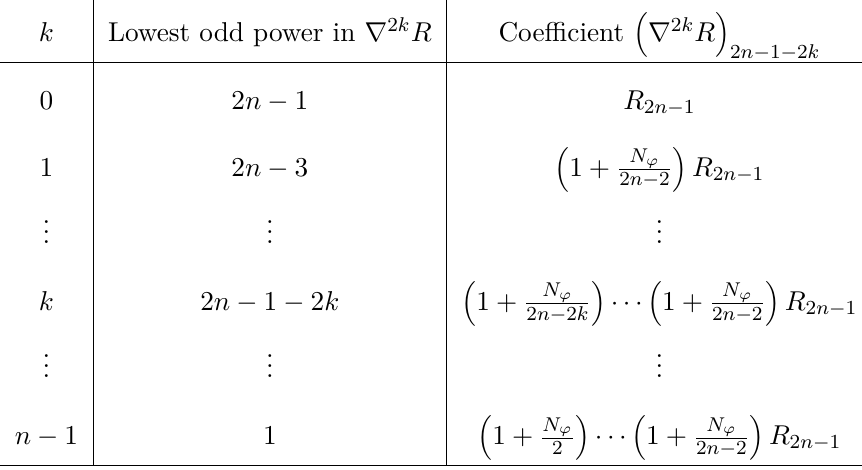
Table 1 . A summary of the relation between the lowest odd power coefficients in the Taylor expansion for ∇ 2 k R in the range 0 ≤ k ≤ n − 1 , and the relation to R 2 n − 1 . There is a similar table for ∇ 2 k V , which can be obtained by making the replacement R → V and n → n + 1 in the